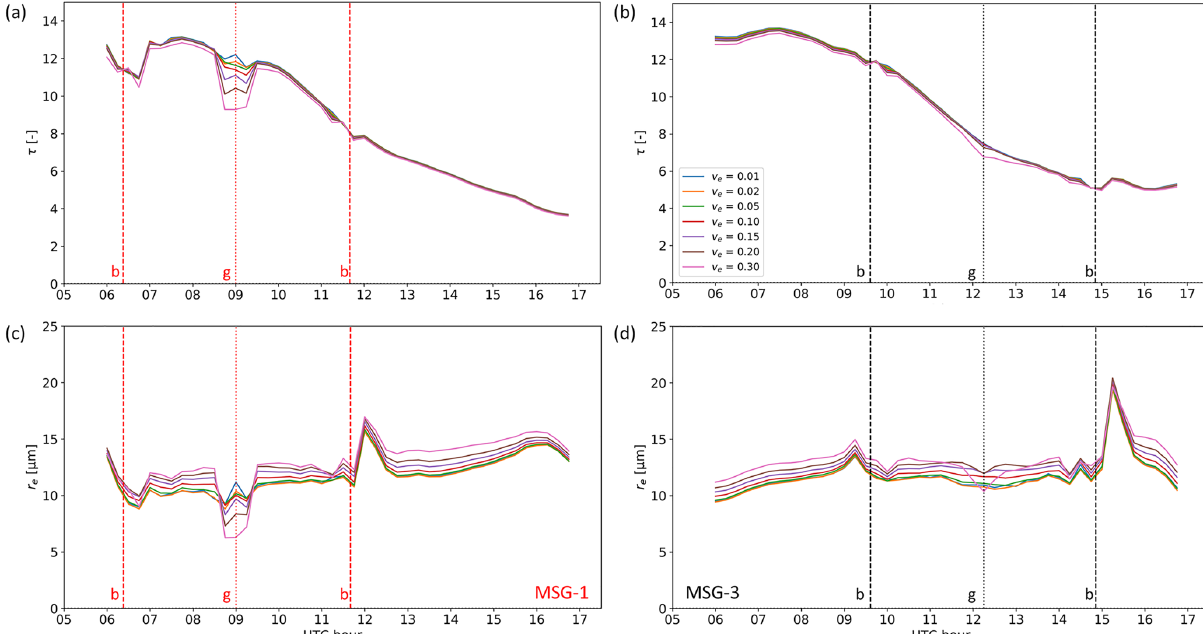
Figure 8. CPP retrievals of τ (a, b) and r e (c, d) based on the 0.6–1.6µm channel combination, shown separately for MSG-1 (a, c) and MSG-3 (b, d) , for the seven values of ν e examined on 7 March 2017 over the southeastern Atlantic. The seven ν e values are shown in (b) . The vertical lines represent cloud glory (dotted, denoted with “g”) and cloud bow (dashed, denoted with “b”) geometries for MSG-1 (red) and MSG-3 (black), as in Fig. 2.